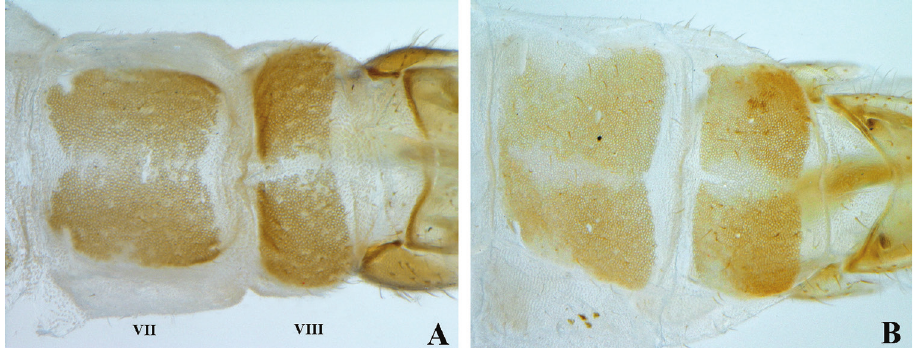
Figure 3. Abdominal terga VII–VIII of Nolima species. A Nolima infensa B Nolima victor